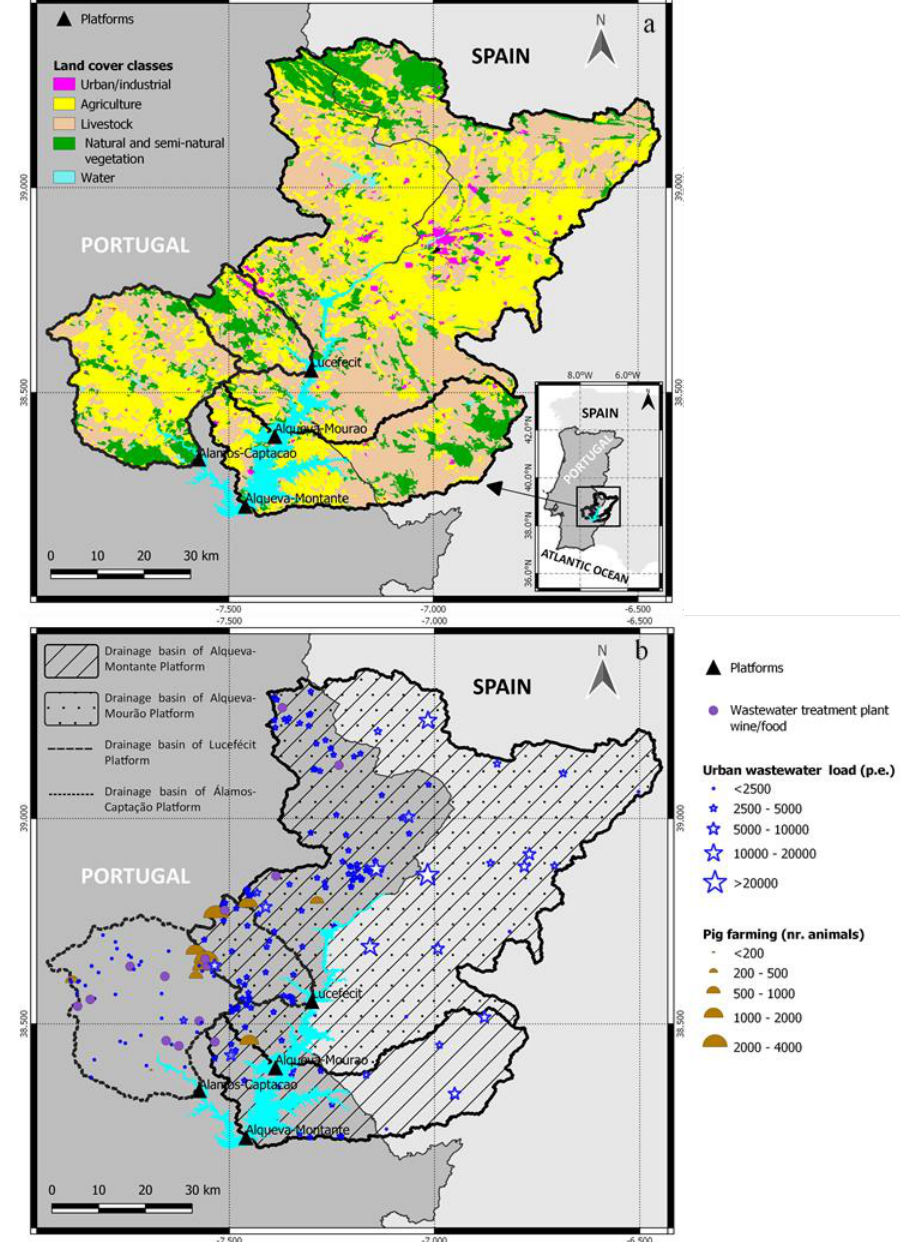
Figure 1. ( a ) Map of the study area located in Alentejo region. The black triangles indicate the platforms, from North to South: Lucefécit; Mourão; Á lamos and Montante and the land cover classes are represented by the colors indicated in the legend. Bottom-right inset shows the study area location in the map of Portugal. ( b ) Map showing the location of the industrial wastewater treatment plants (wine and food related), the urban wastewater loads and the number of animals in pig farms distributed in the four drainage basins indicated in the legend.